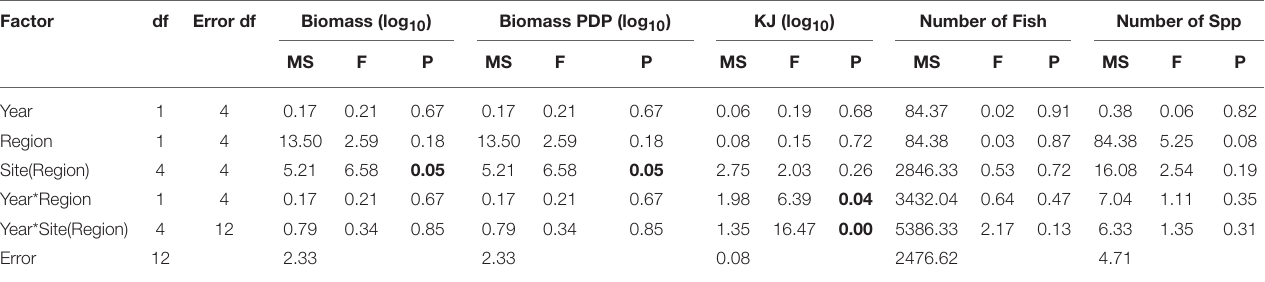
TABLE 8 | Summary of the results of nested ANOVAs to test for annual differences across winter seasons in the biomass, PDP biomass, KJ, number of fish, and number of species caught in gillnets between years and among regions and sites within region. Factor df Error df Biomass (log 10